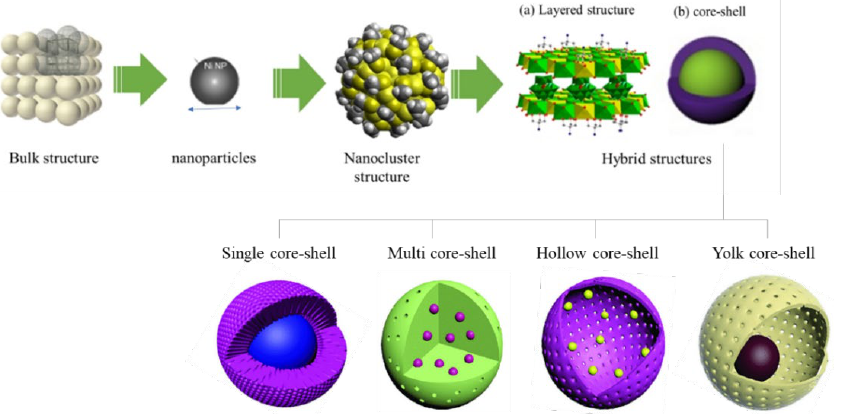
Figure 2. Evolution of catalyst surface engineering, which plays a role in catalyst design strategies: ( a ) layered double hydroxide (LDH) and ( b ) core-shell as new and promising catalyst structures for enhancement of thermocatalytic CO 2 reactions. Illustration of different types of core-shell with different multifunctionalities is reproduced from Das et al. [4], Core-shell structured catalysts for thermocatalytic, photocatalytic, and electrocatalytic conversion of CO 2 ; published by the Royal Society of Chemistry, 2020.